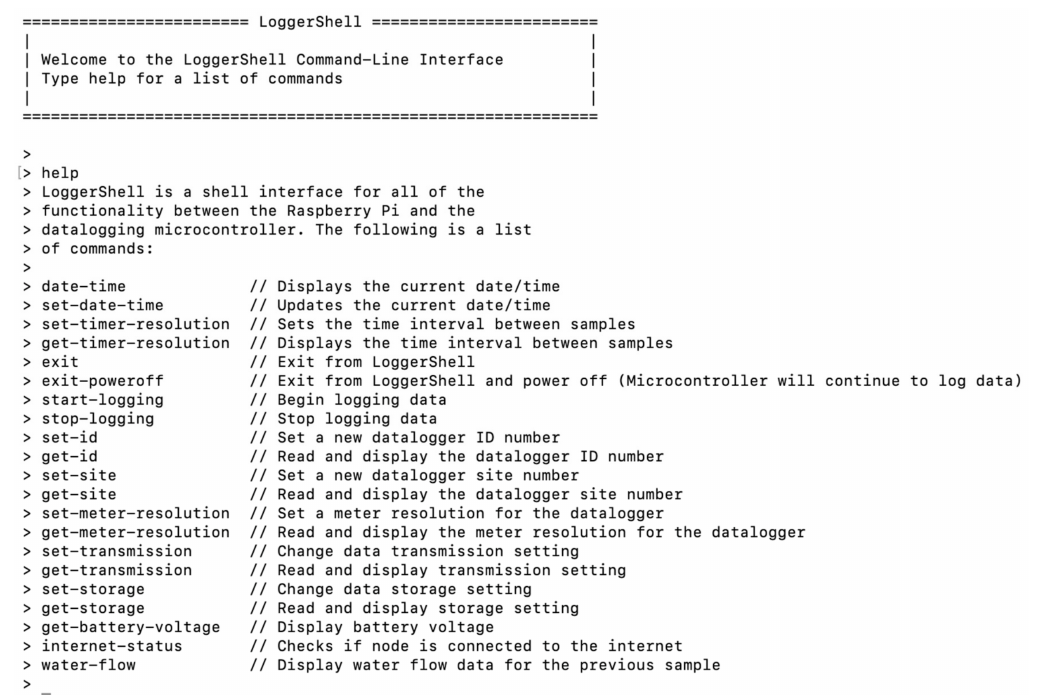
Figure 6. CIWS computational node user interface help menu showing available